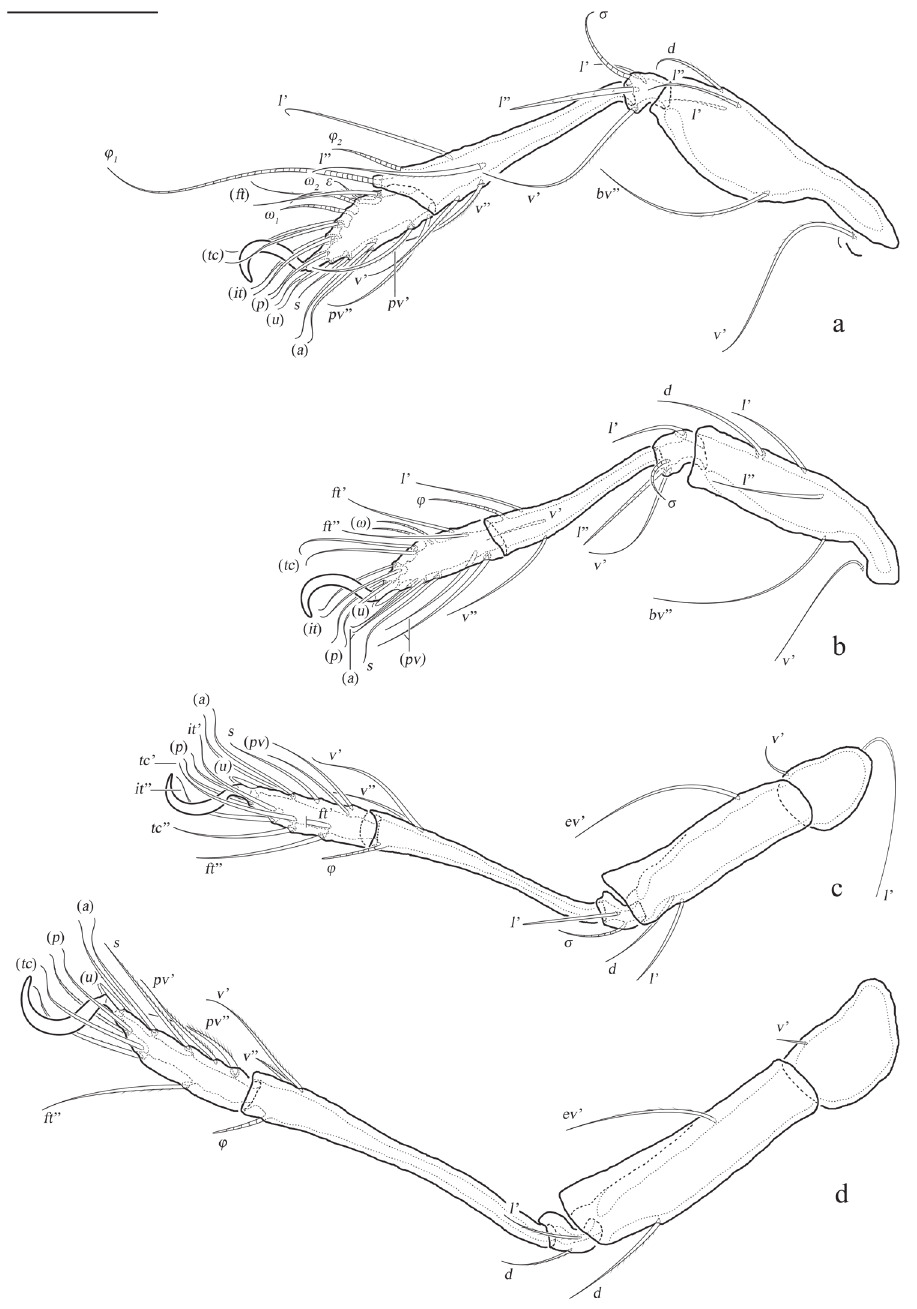
Figure 5. Basiceramerus ovatus sp. nov., adult: a–d leg I–IV, left, antiaxial view. Abbreviations and nota- tions explained in text. Scale bars: 100 μm ( a–d